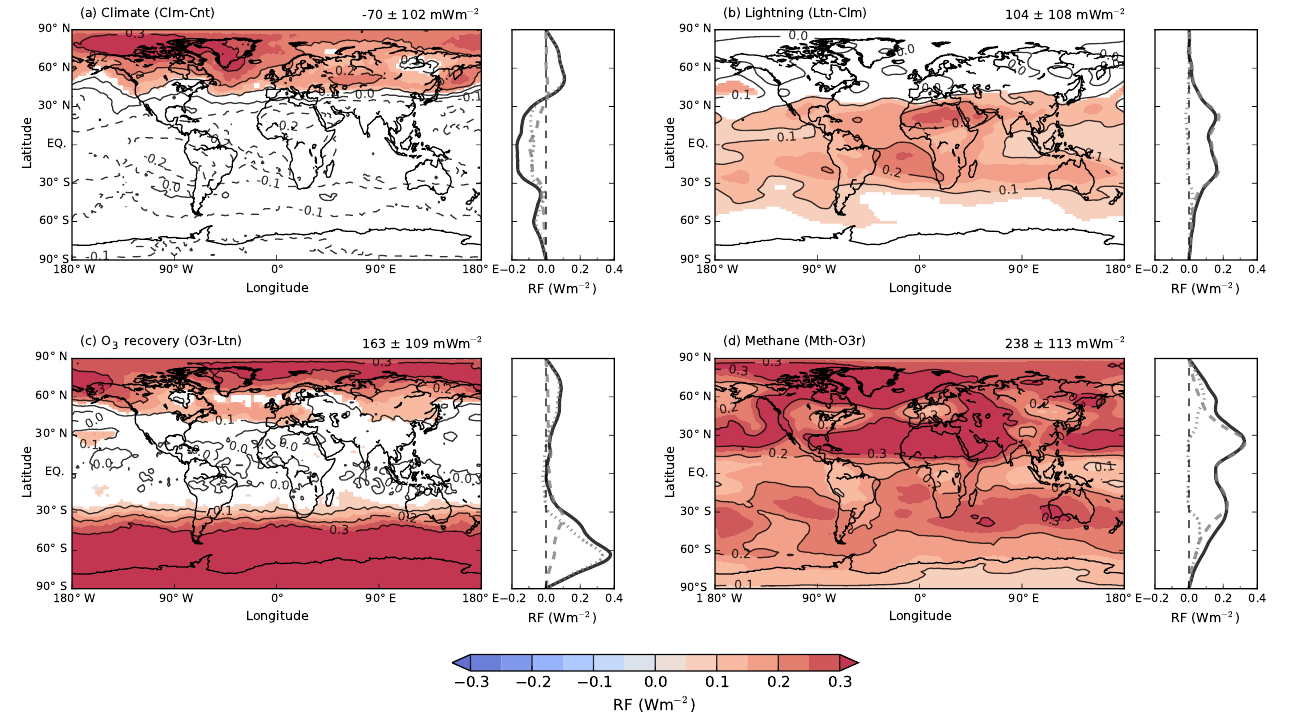
Figure 4. Annual mean maps of ozone radiative forcing (whole atmosphere) due to (a) climate, (b) lightning, (c) O 3 recovery, and (d) methane. Contour colours are for statistically significant changes at the 95% confidence interval using a two-tailed Student’s t test. The annual global mean is shown on the top right corner (mWm − 2 ) . Right panels show zonal mean ozone forcings for the whole atmo- sphere (solid black), troposphere (dashed grey), and stratosphere (dotted grey). The zonal mean forcings are latitudinally weighted, i.e. cosine (latitudes). Table 3. Global and annual mean ozone RF and the SE a (mWm − 2 ) by driver and region for the 2000–2100 period. Region Source CH b 4 Whole atmosphere Tropo. Strat. Tropo. Strat.